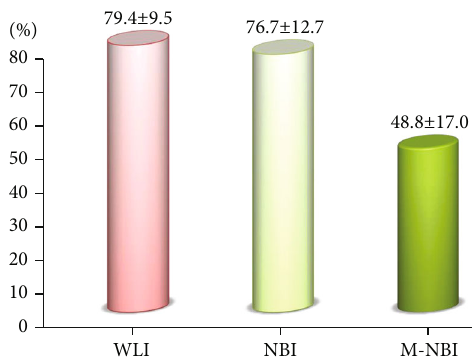
Figure 4: Percentages of mucosal breaks on WLI, nonmagni fi ed NBI, and magni fi ed NBI. NBI: narrow-band imaging; WLI: white- light imaging.